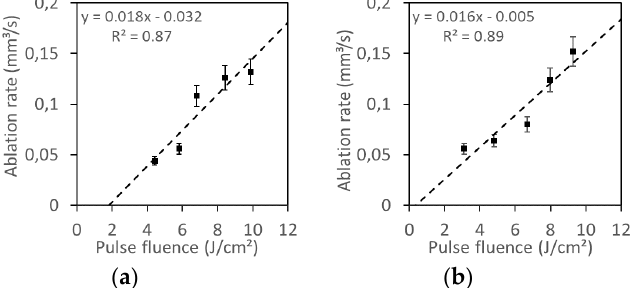
Figure 1. Ablation rate as a function of pulse fluence: Taken from the experiments with the ultraviolet (UV) nanosecond (ns) laser pulses for three different pulse repetition rates: ( a ) 2 kHz; ( b ) 30 kHz; ( c ) 60 kHz.